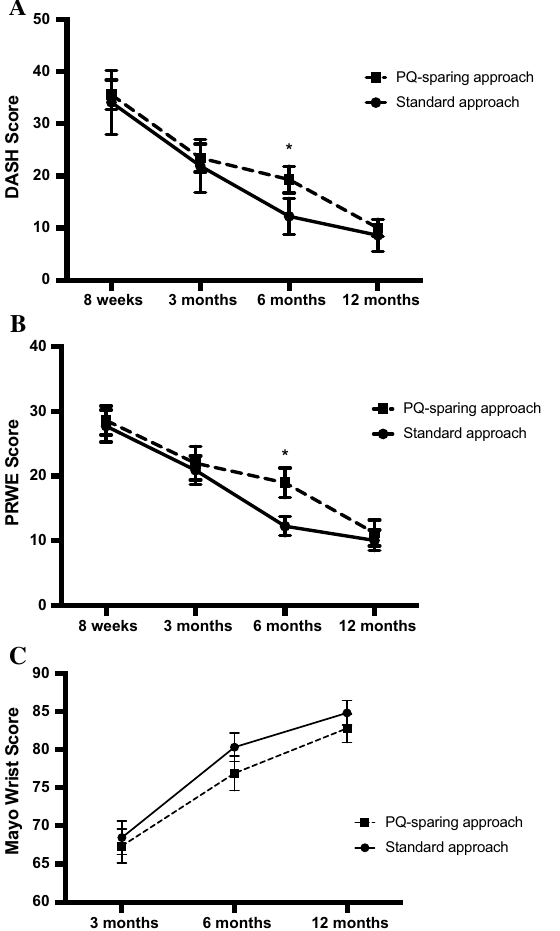
Fig. 3 Graphs showing patient-reported evaluations of the outcomes of treatments for distal radius fractures. A The Patient-Rated Wrist Evaluation (PRWE); B the Disabilities of the Arm, Shoulder, and Hand (DASH) score; C the Modified Mayo Wrist Score. Scores were assessed at the indicated postoperative time points. PQ pronator